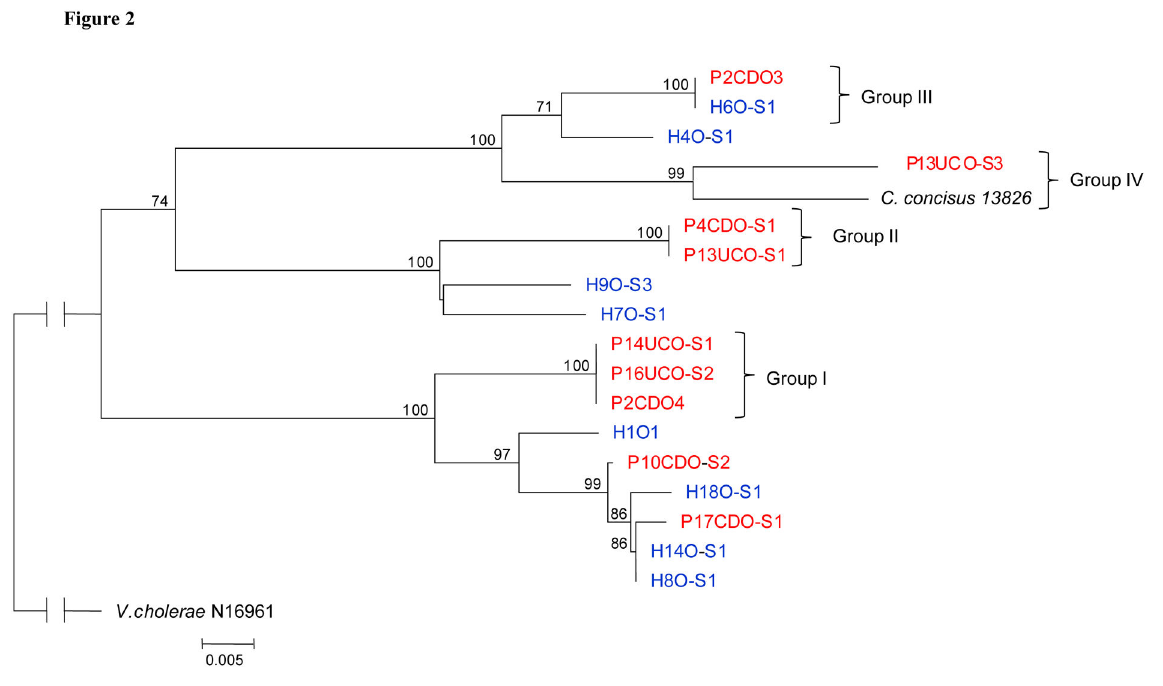
Figure 2. Neighbour-joining dendrogram based on the zot sequences of 17 oral C. concisus strains. Strains from patients with IBD are coloured red. Strains from healthy controls are coloured blue. Groups I, II and III are identical. Vibrio cholerae is used as an outgroup. C. concisus strain 13826 is the whole genome sequenced strain (Accession No. CP000792.1). P2CDO3 and P2CDO4 were from patient No. 2. P13UCO-S1 and P13UCO-S3 were from patient No. 13. The remaining strains were from individual patients and